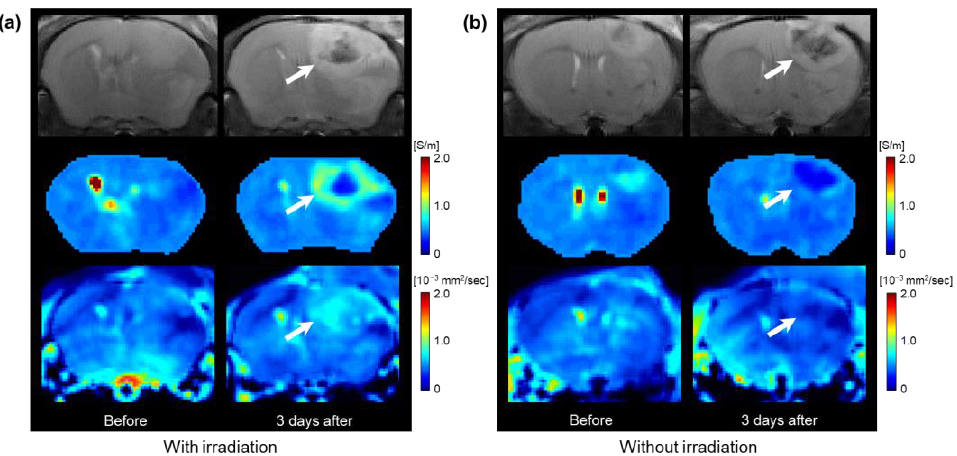
Figure 2. In vivo MR (upper), electrical conductivity (middle), and ADC (lower) images of C6 glioma model mouse brains regarding tissue responses with ( a ) and without ( b ) irradiation. All images were acquired before and 3 days after irradiation. The growth of C6 glioma with central necrosis (white arrows) was observed in the left hemisphere.